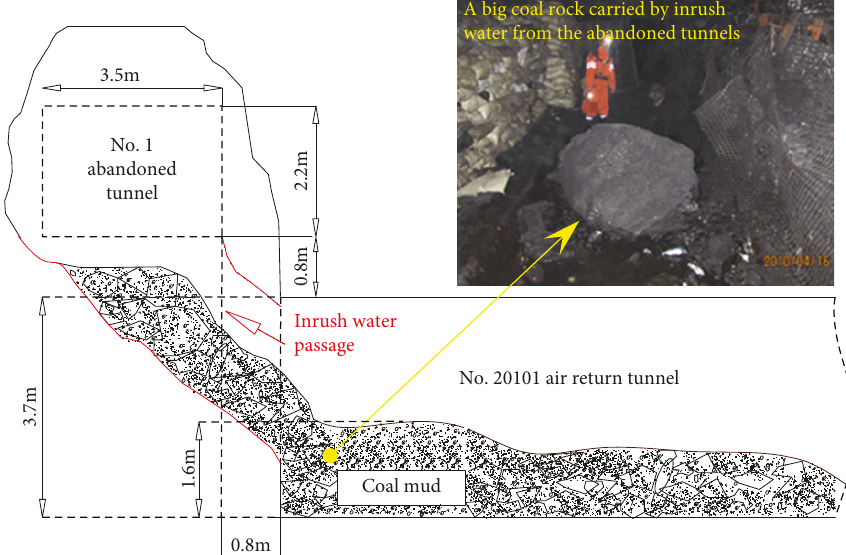
Figure 7: Cross section of the inrush water passage.